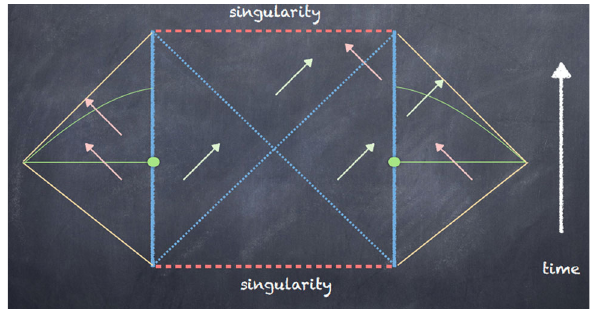
Fig. 4 A pictorial representation of how an information paradox is realized within the framework of eternal black holes. The green and the red quanta are the Hawking pairs that can be detected by a measurement carried out at the boundary. These observations are made at regions denoted by green solid lines on the